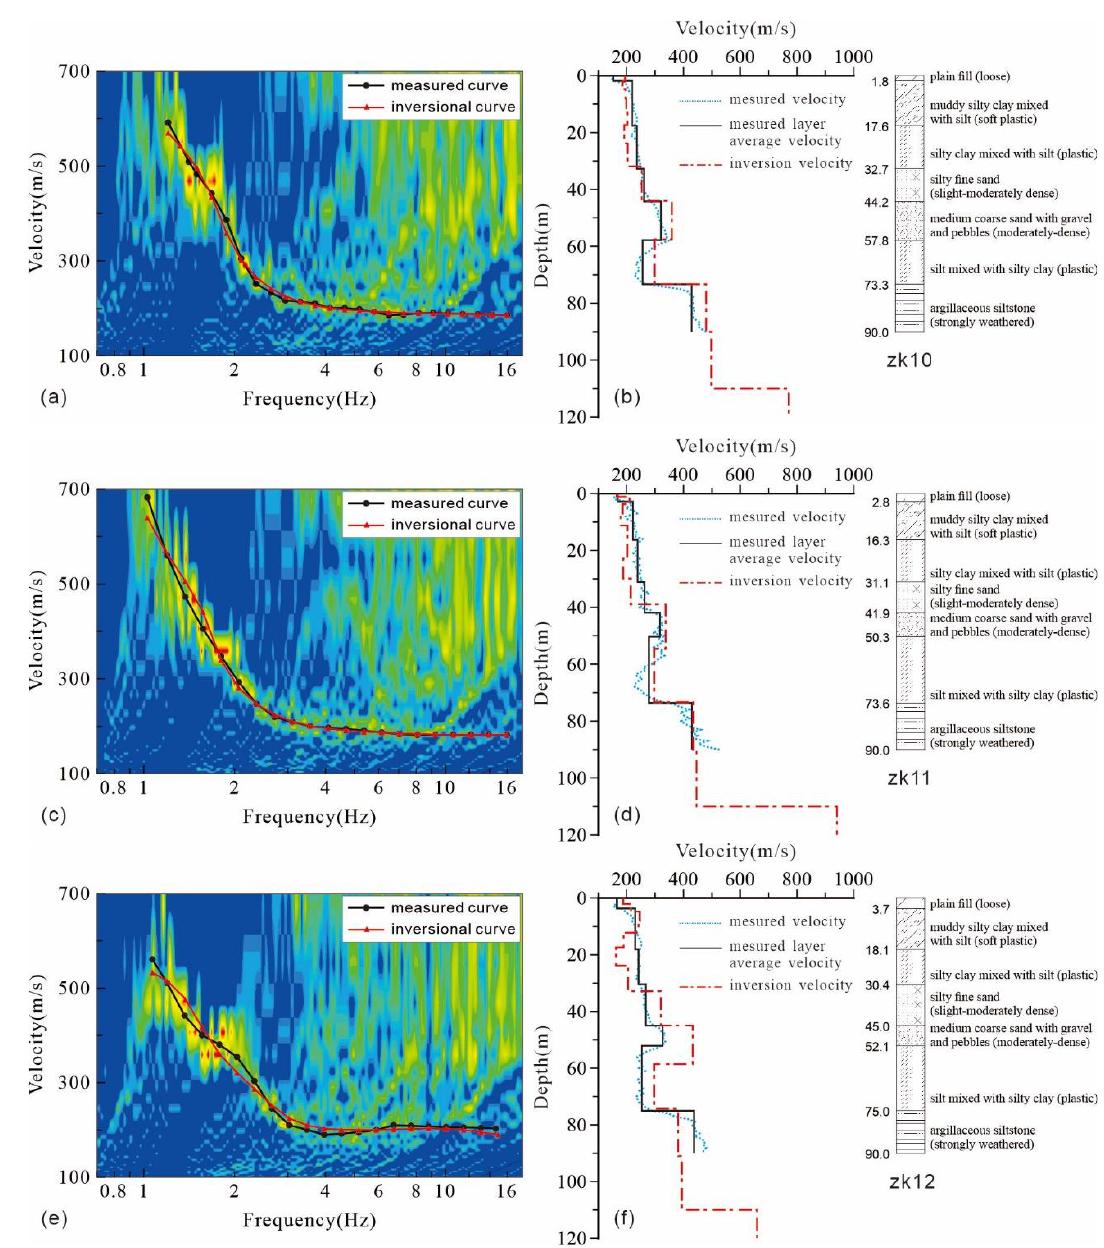
Figure 6. Dispersion curves and inversion results of microtremor exploration points in study area II. ( a ) dispersion curves of S33; ( b ) inversion model of S33 and in situ test results of zk10; ( c ) dispersion curves of S95; ( d ) inversion model of S95 and in situ test results of zk11; ( e ) dispersion curves of S151; and ( f ) inversion model of S151 and in situ test results of zk12.